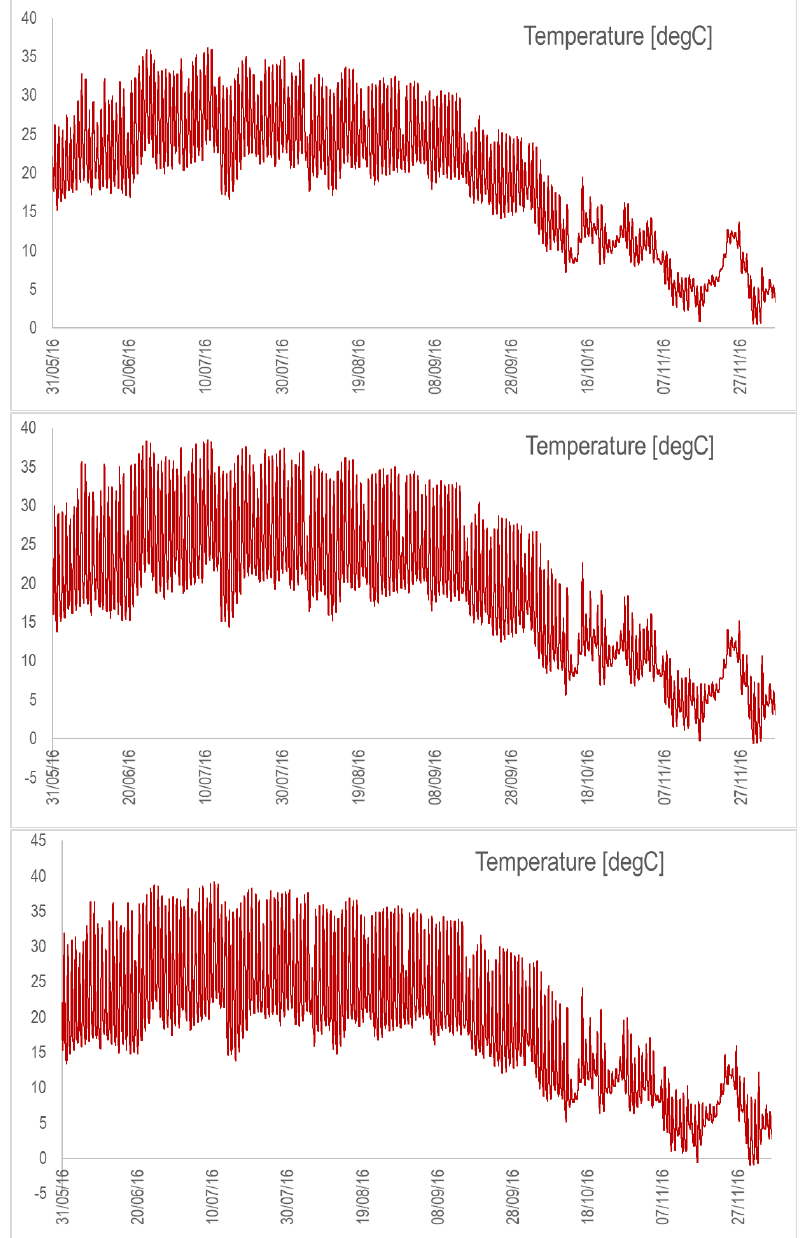
Figure A3. Temperature dynamics for the raceway on the ground with the nominal depth ( top ), depth divided by 2 ( middle ), and depth divided by 3 ( bottom ). Simulations are from May to November